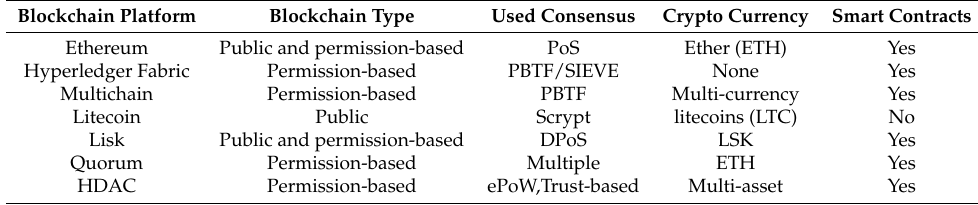
Table 1. Blockchain Platforms for IoT